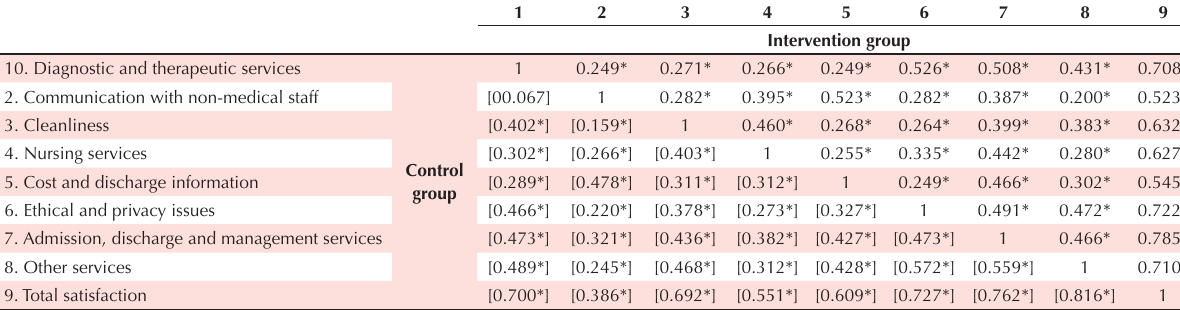
Table 3. The correlation coefficient of satisfaction domain score between the two study